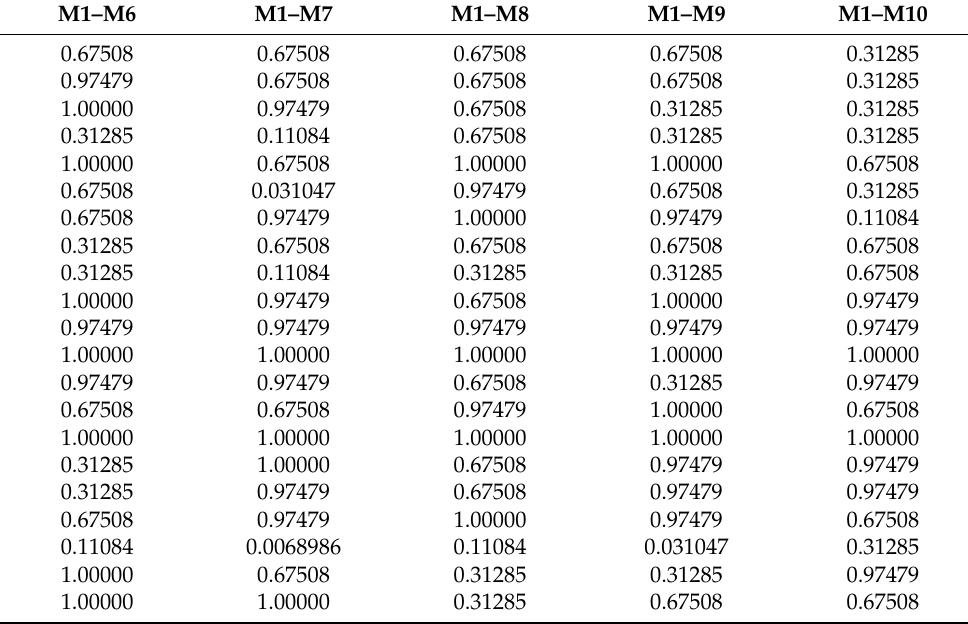
Table A2. p -values of the Kolmogorov–Smirnov test Assumption 2